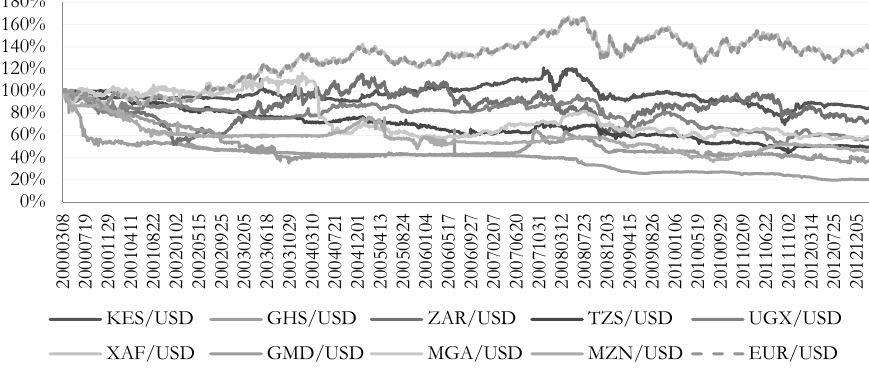
Fig. 1 – Developments of Selected African Currencies between 2000 and 2015 (March 8 2000=100%). Source: